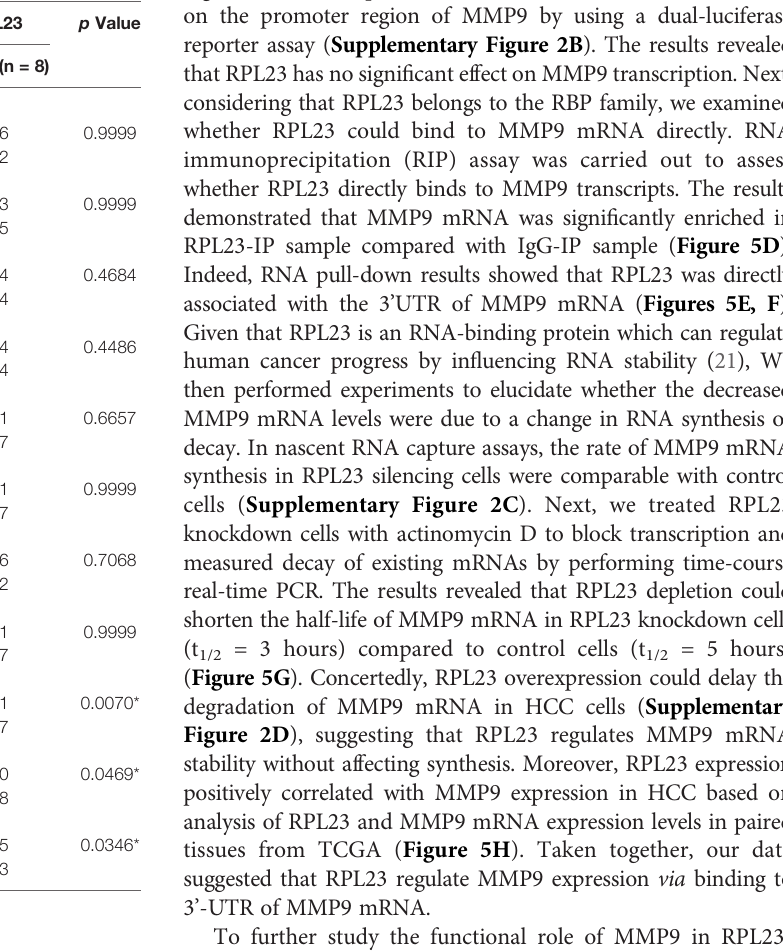
TABLE 1 | Correlation between RPL23 expression and clinicopathological characteristics in HCC